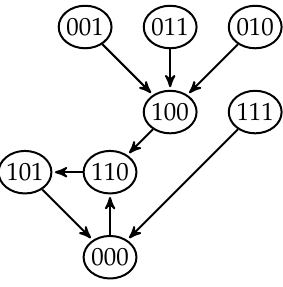
∨ x (cid:48) ∧ x (cid:48) ∧ x ∧ x ) . , x (cid:48) , x (cid:48) 2 1 3 2 3 3 1